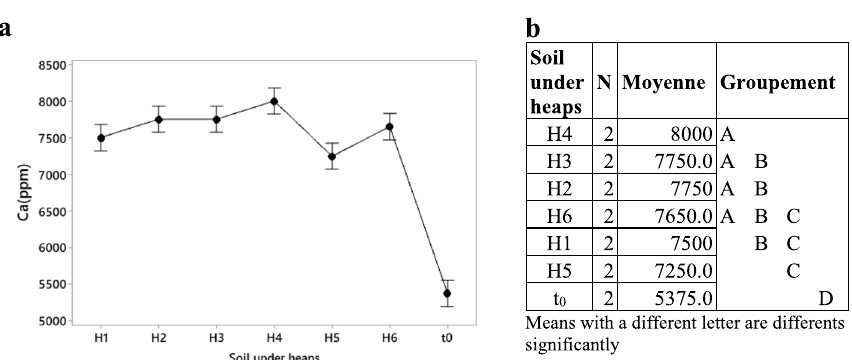
Fig. 7 Statistical tests related to Ca content under the soil (p<0.05) : a confidence intervals related to Ca means under the soil before ( t 0 ) and after composting (under H1 to H6) ( one-way ANOVA test ); b Tukey